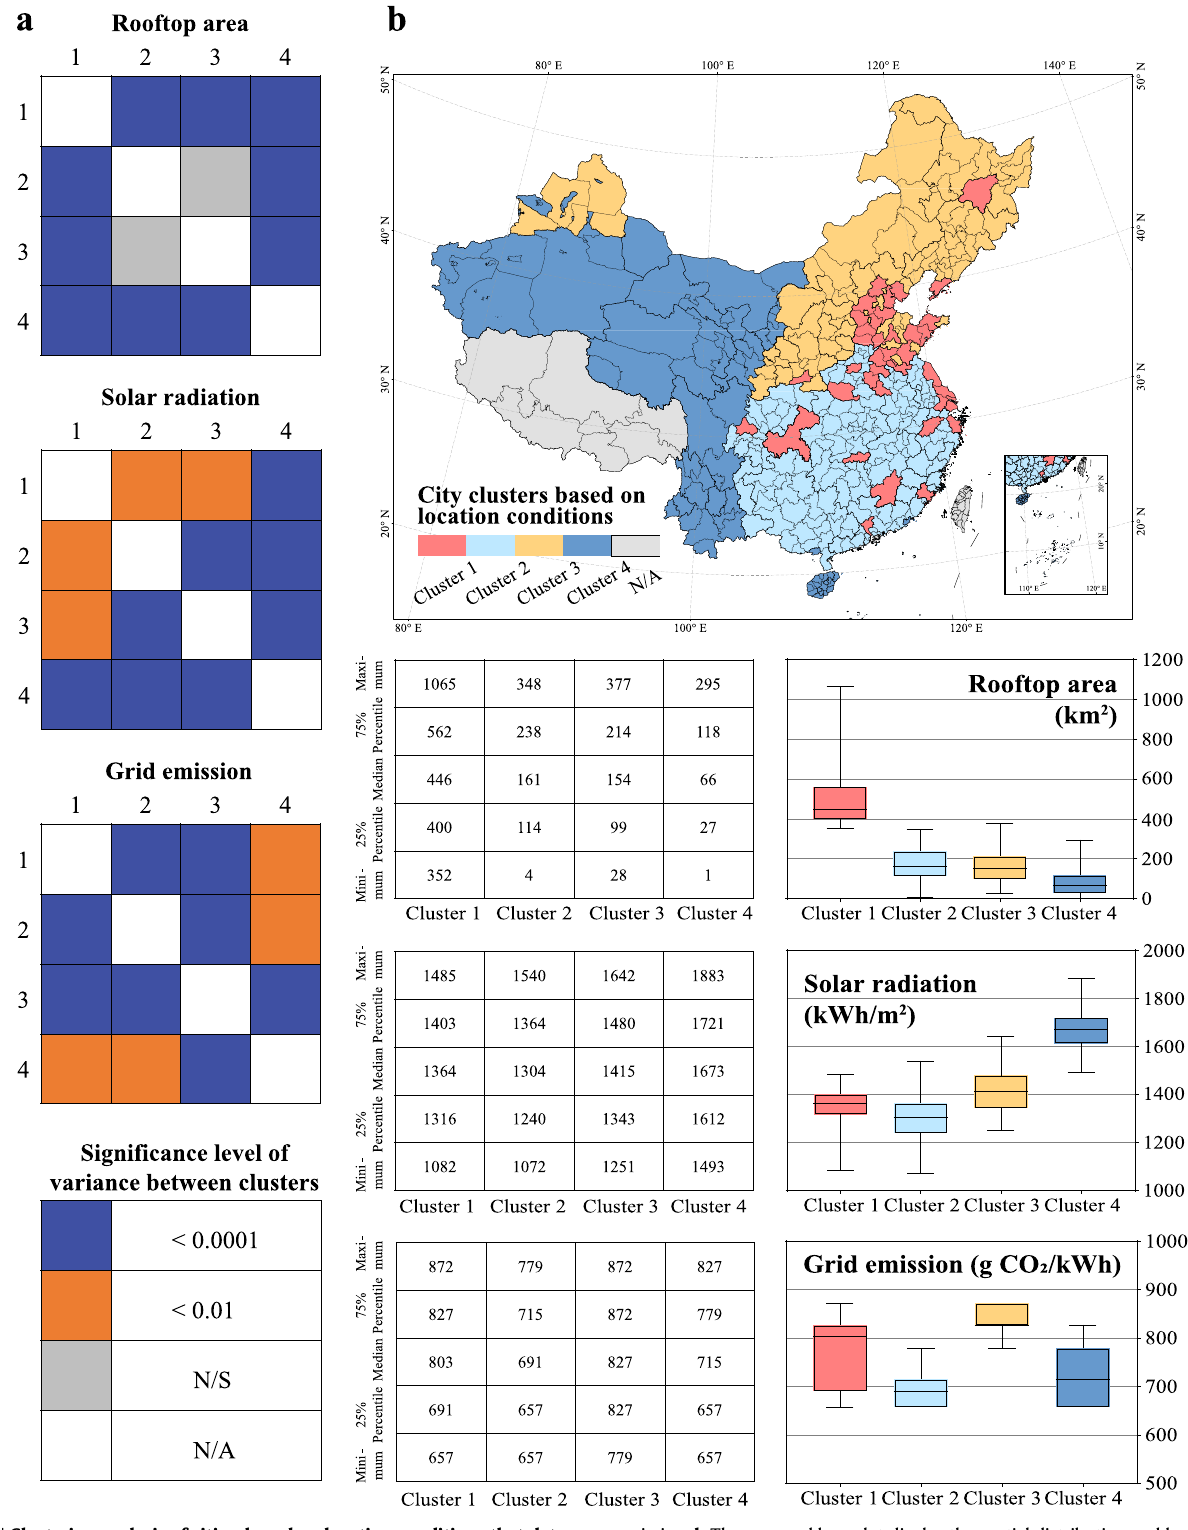
emission. b The map and box plot display the spatial distribution and location condition characteristics of cities in each cluster, respectively. The east – west divisions portray the differences in the rooftop areas and solar radiation intensity, and the north – south divisions portray the differences in the grid-level emissions. Data Credits: All the city administrative boundaries are from